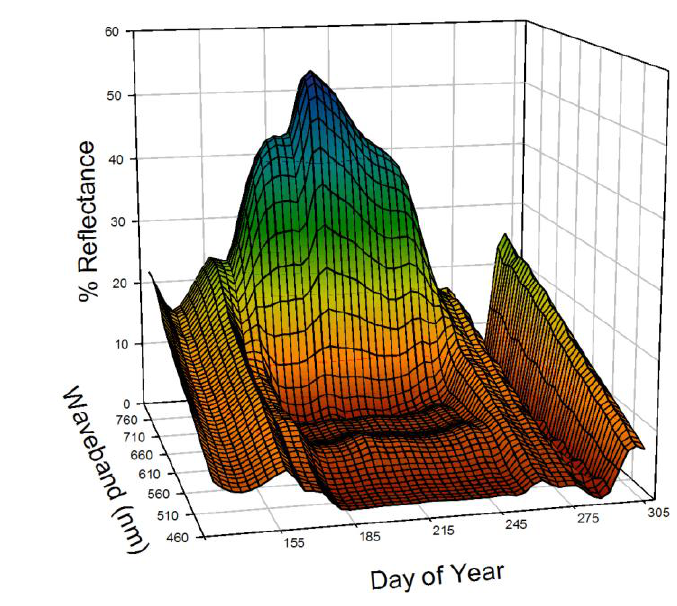
Figure 1. Reflectance over corn obtained throughout the growing season with a CropScan eight-band radiometer over a spring strip tillage system in 2007.